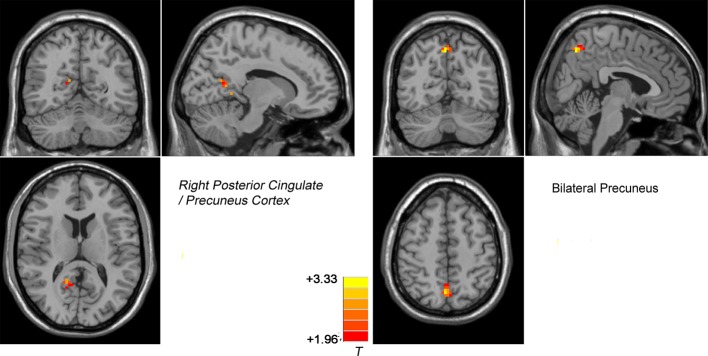
Treatment effects of DMN NH across patients at two point (at baseline and after 8 weeks of treatment). The color bar represents the t value of the group analysis of NH. Left: DPP group from baseline to 8 weeks. Brain regions with significant difference in the NH values were observed in the right Precuneus/PCC. Right: DT group vs DPP group at 8 weeks. Brain regions with significant difference in the NH value were observed in the bilateral Precuneus.